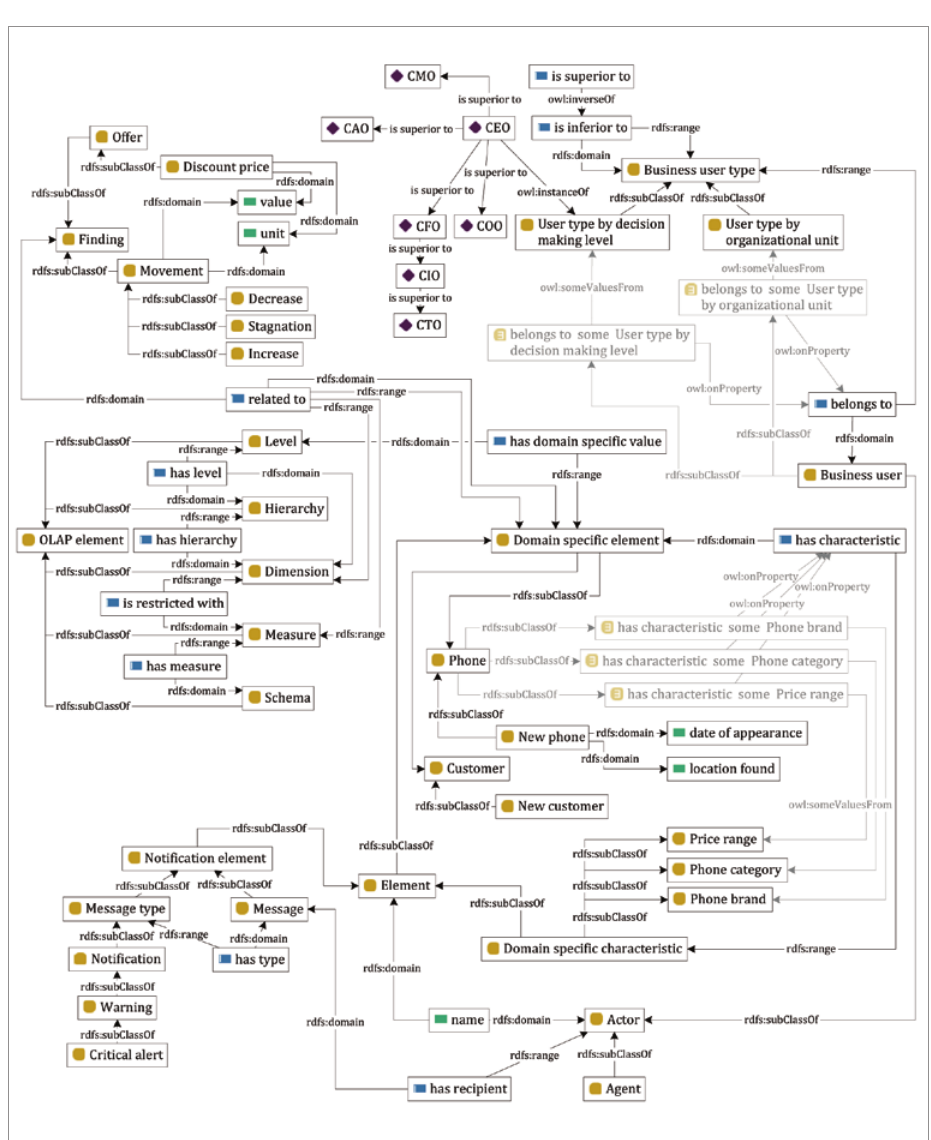
Fig. 2. Excerpt from intersection of several ontologies used in our case